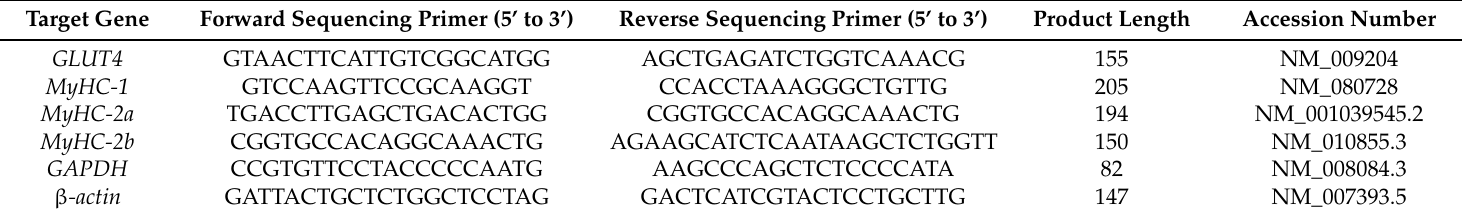
Table 1. List of primers used for validation of gene expression using quantitative real-time